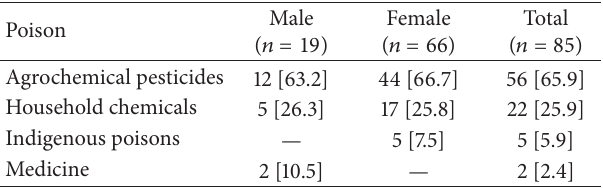
Table 2: Profile of the poisons used in the deliberate self-harm acts. Poison